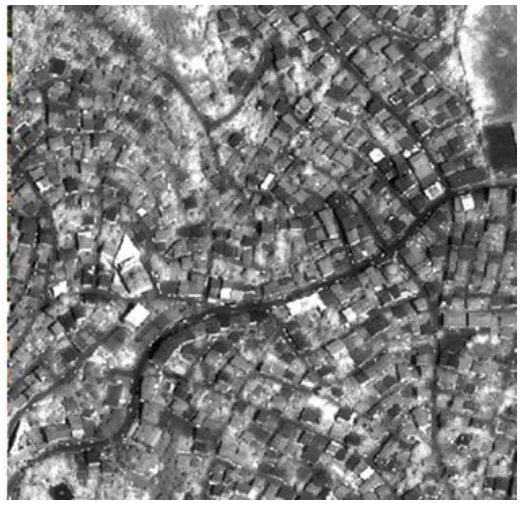
Figure 3. NIR band image